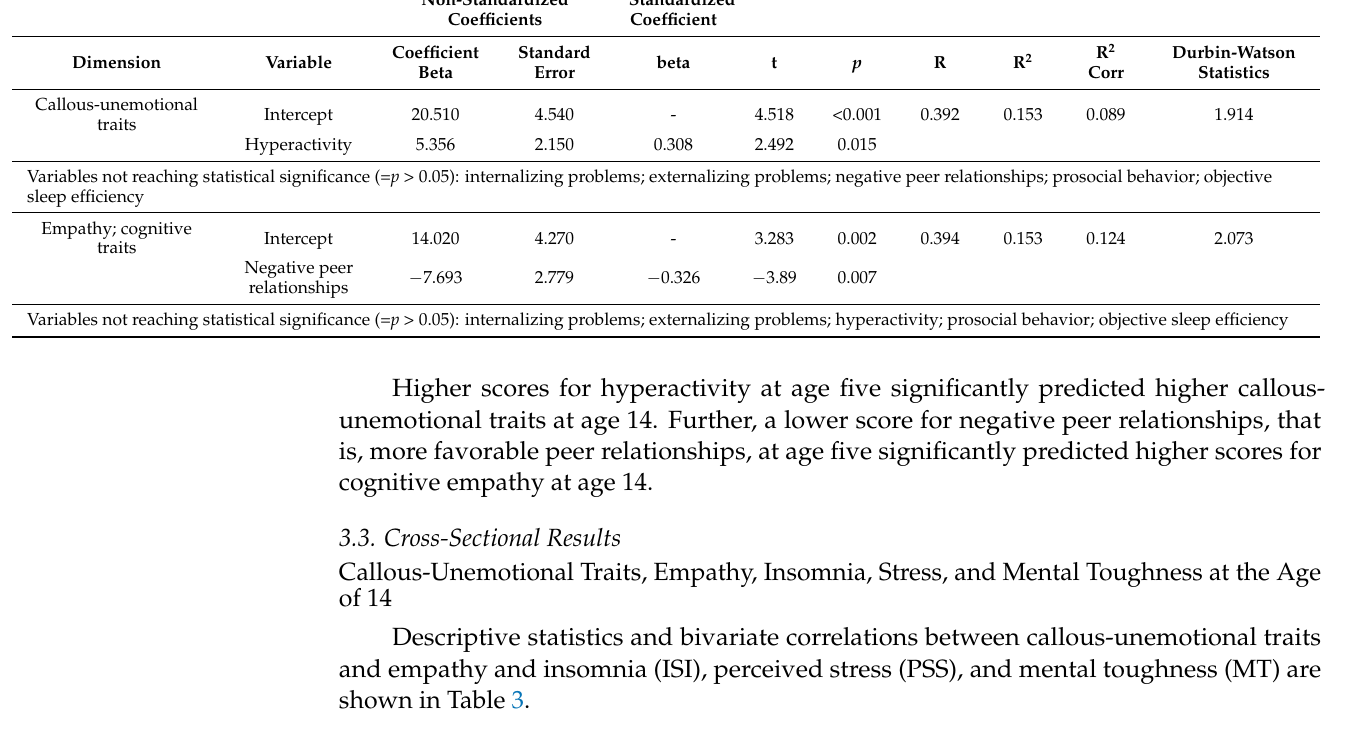
Table 3. Correlations between callous-unemotional traits and empathy and insomnia, perceived stress and mental toughness at age